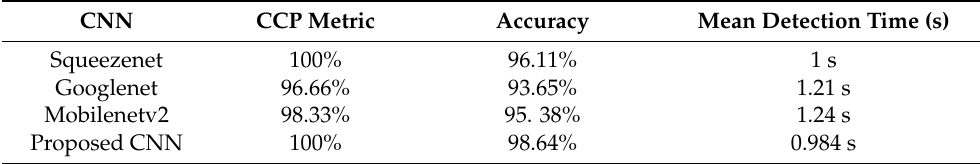
Table 6. Fast RCNN detector obtained